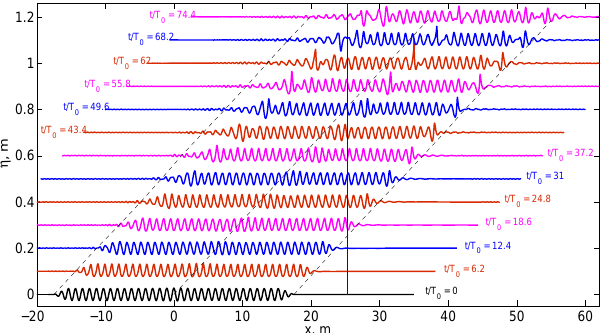
Figure 2. The temporal evolution of the surface elevation η in a fixed reference frame; wave parameters as in Fig. 1. The vertical line marks the location of the wavemaker at x = x wm = 25 . 273m; broken lines correspond to propagation with the group velocity c g .